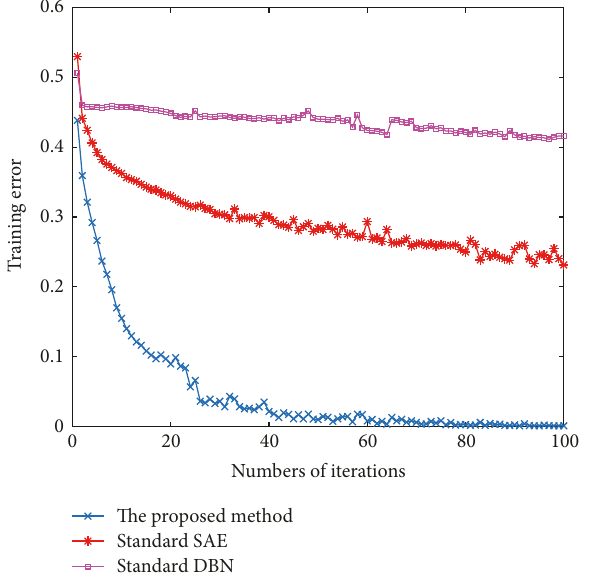
Figure 9: Curves of the training error of the proposed method, standard SAE method, and standard DBN method.